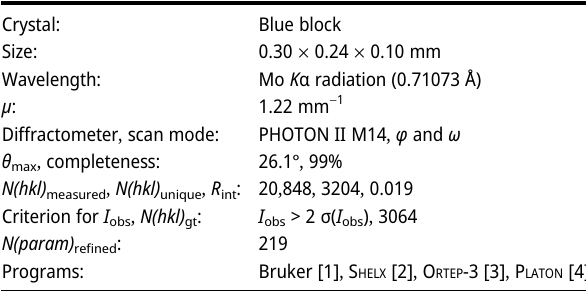
Table  : Data collection and handling. Table  : Fractional atomic coordinates and isotropic or equivalent isotropic displacement parameters (Å 